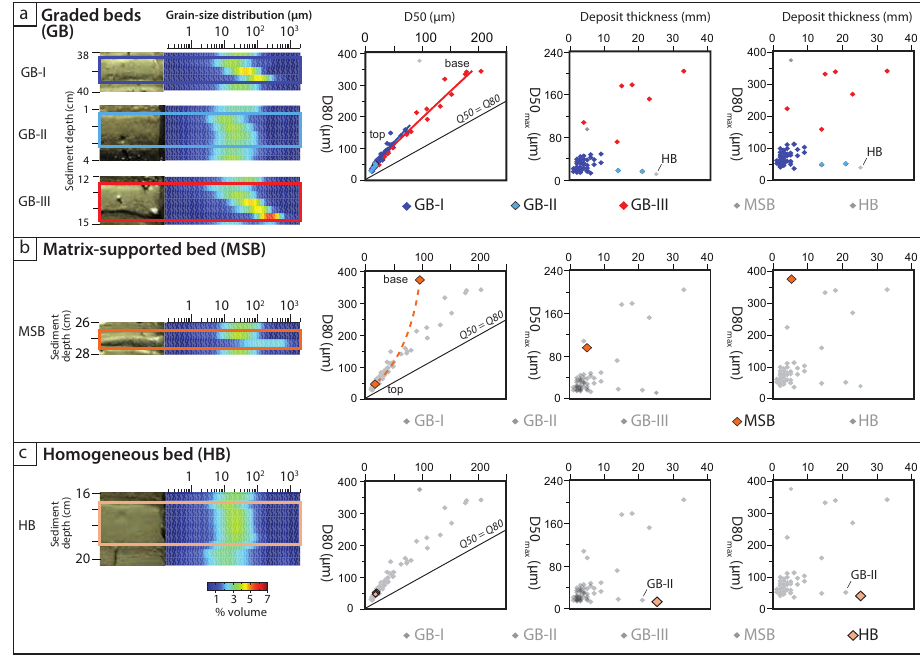
Figure 4. Close-eye views of event layers (left) and their positions in a Passega-type (Q50 vs. Q80) diagram as well as in “percentile vs. deposit thickness” diagrams (right) for the graded beds (a) , the matrix-supported bed (b) and the homogenous bed (c) .